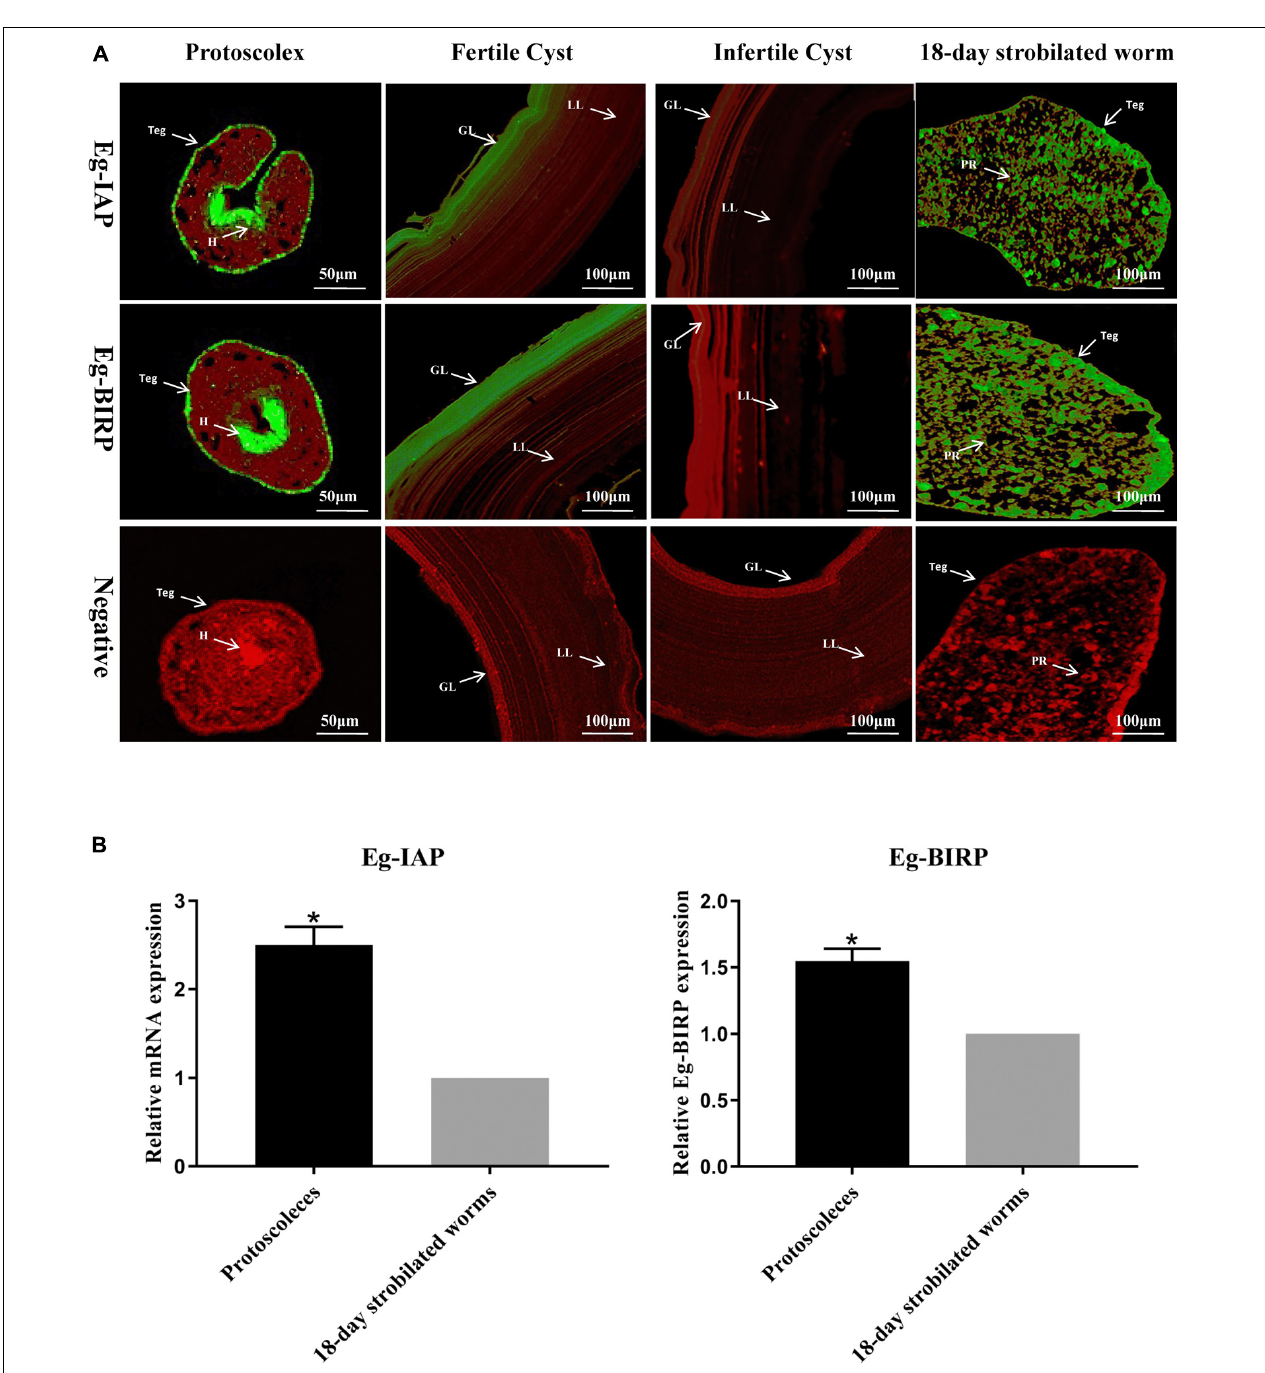
FIGURE 2 | Immunolocalization and Transcription levels of Eg-IAP and Eg-BIRP in E. granulosus. (A) Fluorescence immunohistochemistry analysis of Eg-IAP and Eg-BIRP at different stages of E. granulosus life cycle. rEg-IAP/rEg-BIRP were localized on the protoscolex, fertile/infertile cyst walls, and 18-day strobilated worm using specific anti-rEg-IAP/anti-rEg-BIRP rabbit sera IgG or pre-immune rabbit sera IgG. Abbreviations: H, hooks; LL, laminated layer; GL, germinal layer; Teg, tegument; PR, parenchymal region. Note, Fluorescence-labeled regions were marked with arrows. (B) qRT-PCR analysis of transcription levels of Eg-IAP and Eg-BIRP at PSCs and 18-day strobilated worms stages. Data are presented as the means ± SD ( n = 3). Statistically significant differences between PSCs and 18-day strobilated worms were determined using Student’s t -tests (* p < 0.05).